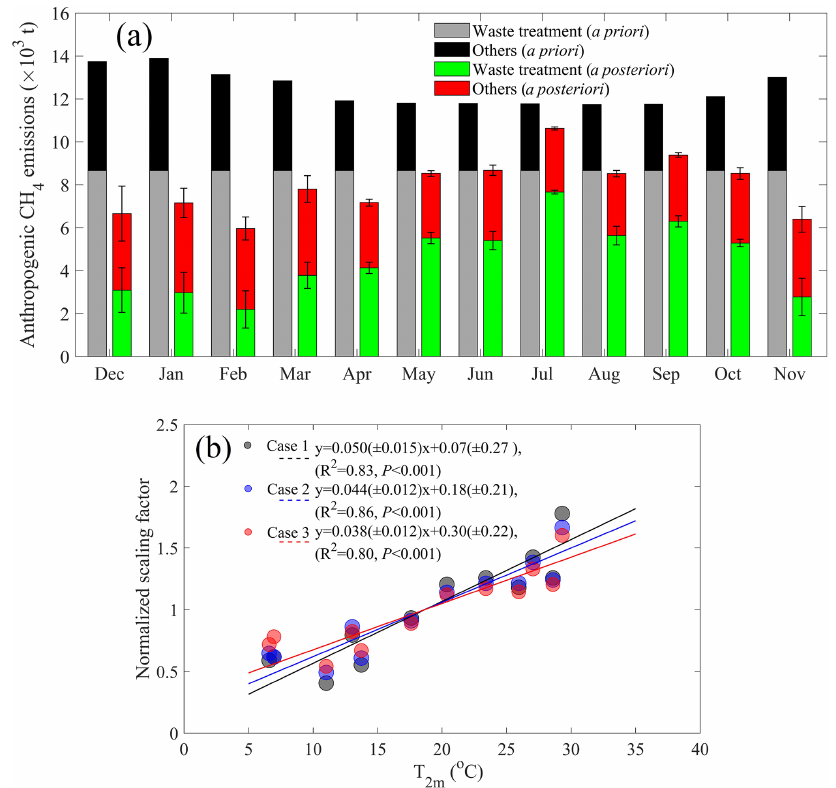
Figure 7. (a) Monthly anthropogenic (excluding agricultural soil) CH 4 emissions for a priori and a posteriori emissions for Hangzhou; (b) relationship between the monthly a posteriori CH 4 emissions and temperature for the three cases discussed in Sect. 2.3 of this